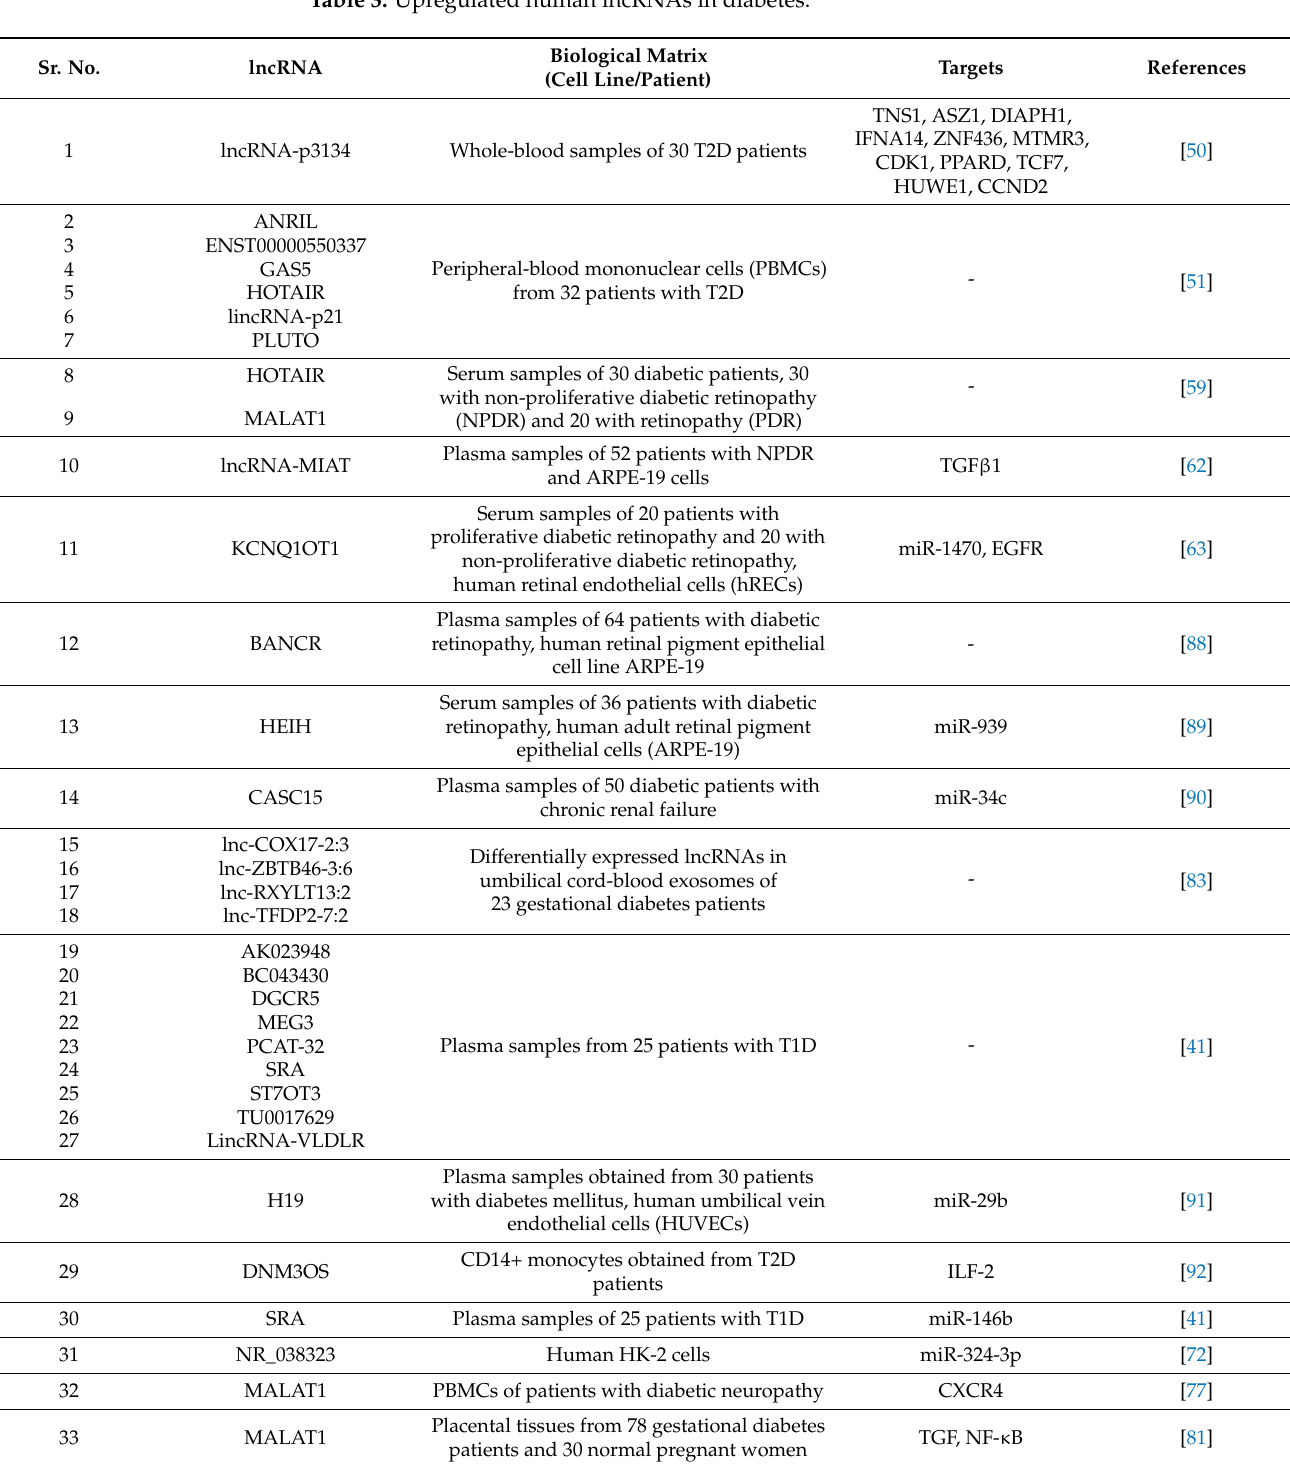
Table 3. Upregulated human lncRNAs in